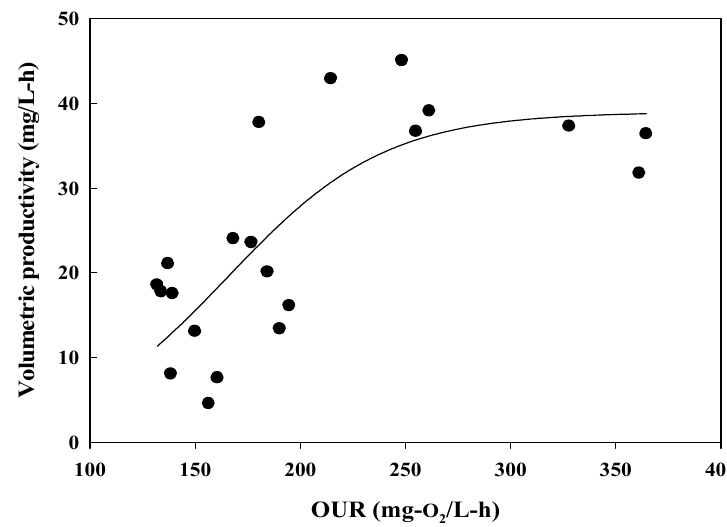
Figure 2. Relationship between oxygen uptake rate (OUR) and volumetric surfactin productivity.